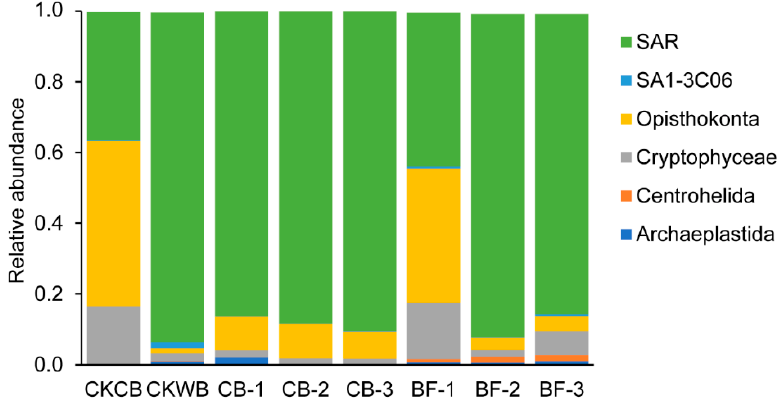
Figure 7. Composition of dominant eukaryote